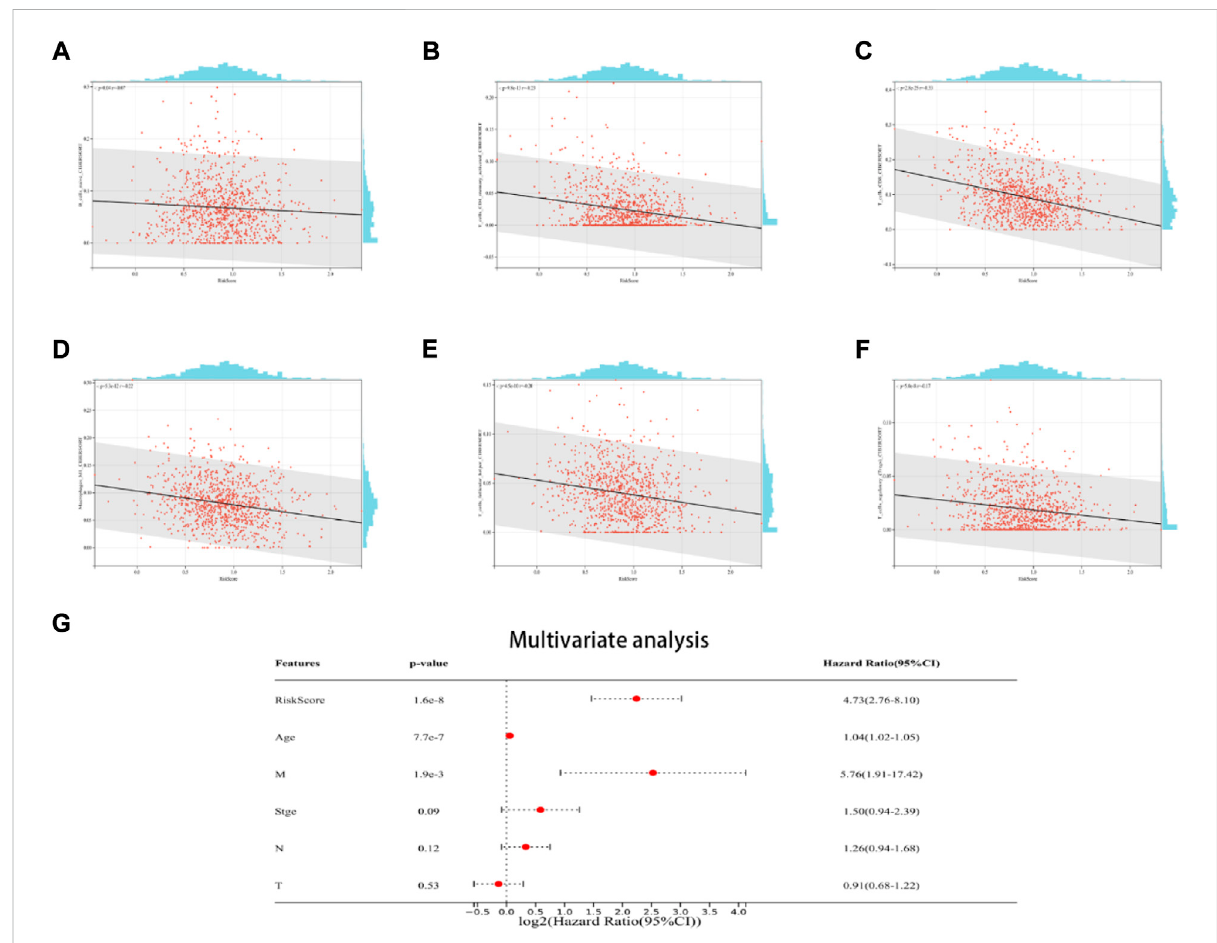
FIGURE 6 The relationship between the TME and ICD risk signature. Scatter plots in (A – F) illustrate the relationship between risk score and the in fi ltration status of activated CD4 memory cells, native B cells, CD8 cells, helper follicular T cells, M1 macrophages, and regulatory (Tregs) T cells; (G) : Multivariate Cox regression analysis assess the prognostic value of the ICD risk signature in BRCA patients in an independent